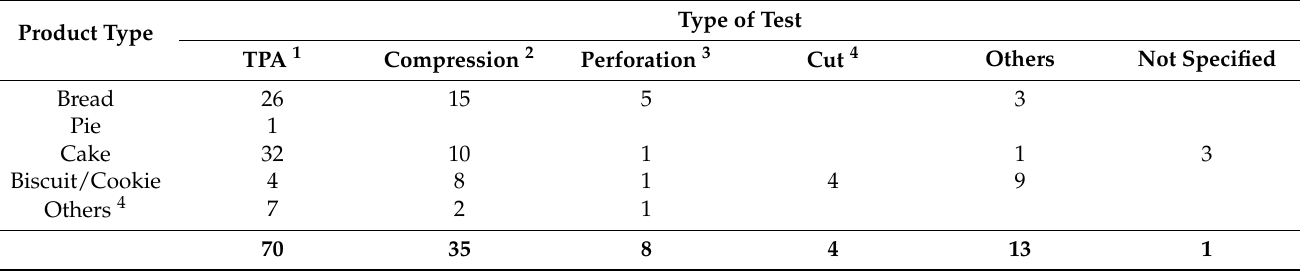
Table 2. Number of studies according to the method used for the instrumental measurement of